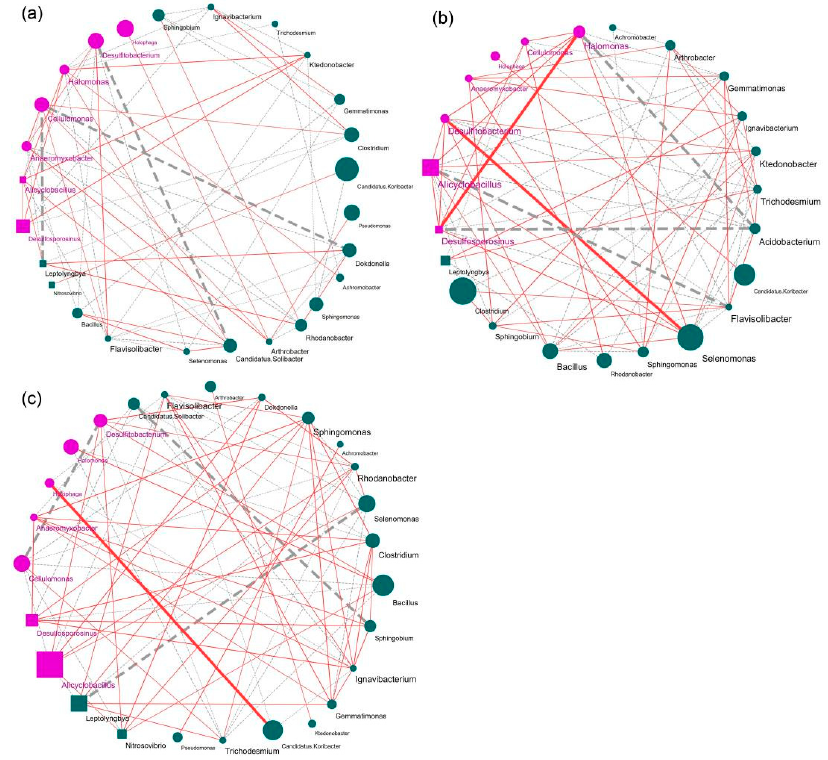
Figure 6. Co ‐ occurrence network diagram of soil top 30 bacterial genera between different Fe(II) concentration systems, and we classify microorganisms according to their type of oxygen demand and mode of nutrition. We define the treatment of LCK and SCK as an integrated system (LSCK) ( a ). Similarly, Fe (II) low additive treatment is LSL ( b ); Fe (II) high additive is an integrated system of LSH ( c ). We construct separate network diagrams based on an integrated system. Based on Spear ‐ man correlation, Cytoscape was used to construct bacterial co ‐ occurrence network. Correlation is shown as edge (positive correlation = red; Negative correlation = gray), correlation coefficient r > |0.9|, and p < 0.01. Node colored by the category of anaerobic or other taxa, and the shape of the node is divided into chemoautotrophic and other taxa. The size of nodes is positively correlated with relative abundance of genus. The width of the link represents the correlation strength between microbes at genus level, to find the keystone genera within networks. genus level, to find the keystone genera within